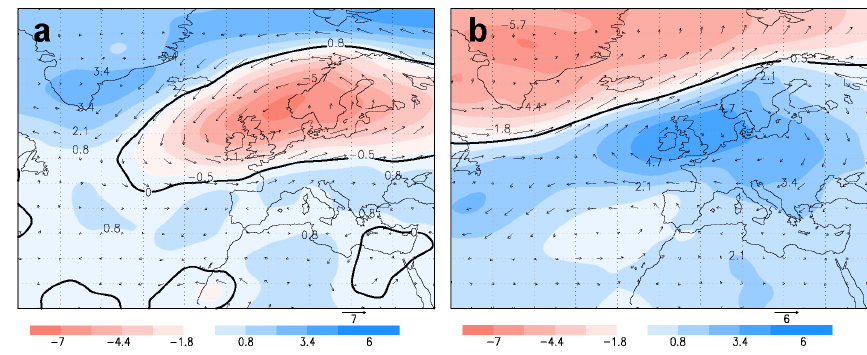
Fig. 8. Composite maps of SLP (hPa) and wind (ms − 1 ) at 850hPa for CDD (PC2) (a) and for the NAO (b) in